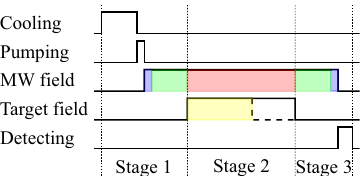
Fig. 4 Accuracy analysis for continuous data acquisition. a Regression of y the fi t line (blue) and the correlation coef fi cient R are shown. b Histogram of 20 outputs y 1 from the NN for the case a 1 = (2 π ) × 2.1572 kHz denoted with a vertical red line.